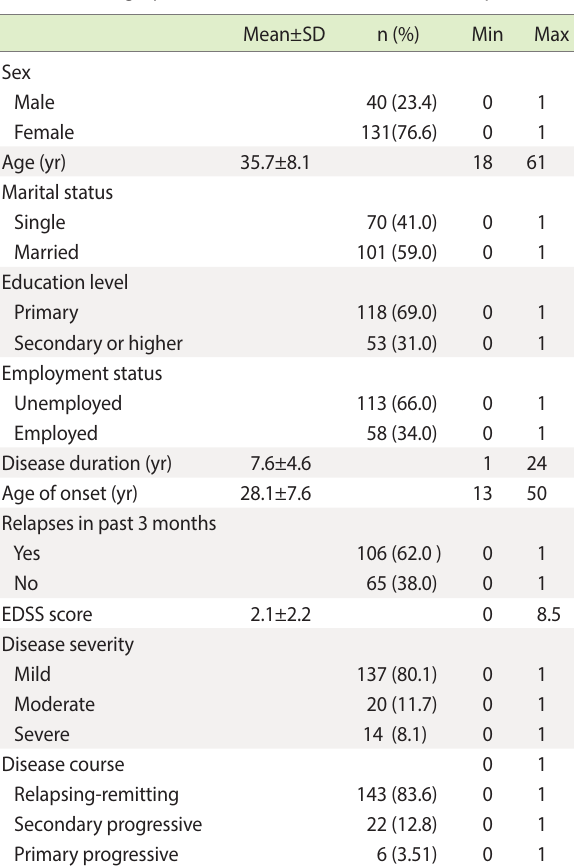
Table 1. Demographic and clinical characteristics of the patients